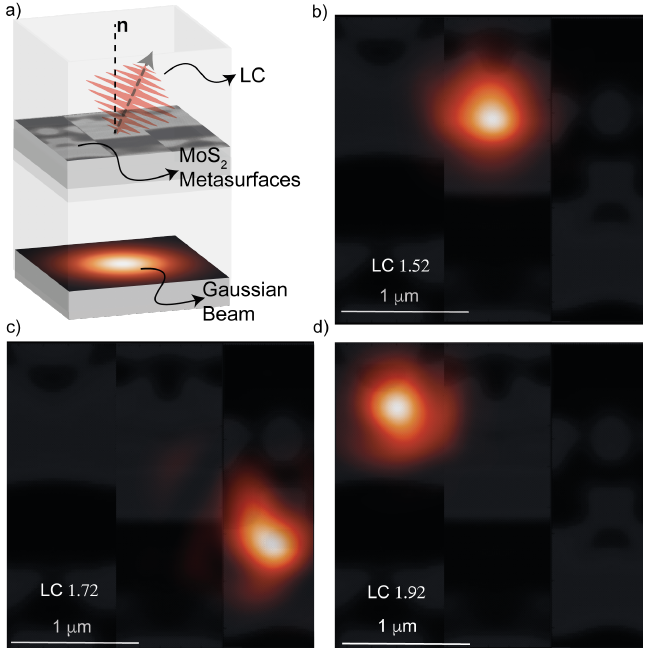
Figure 2. ( a ) Schematic illustration of the operation of the proposed device. ( b – d ) Numerical transmitted beam position for three different LC refractive index